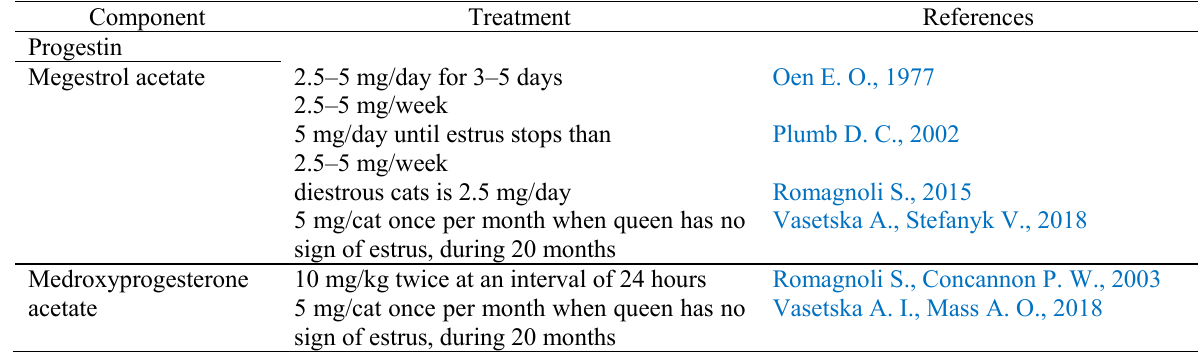
Drug regimens for various progestins in cats Component